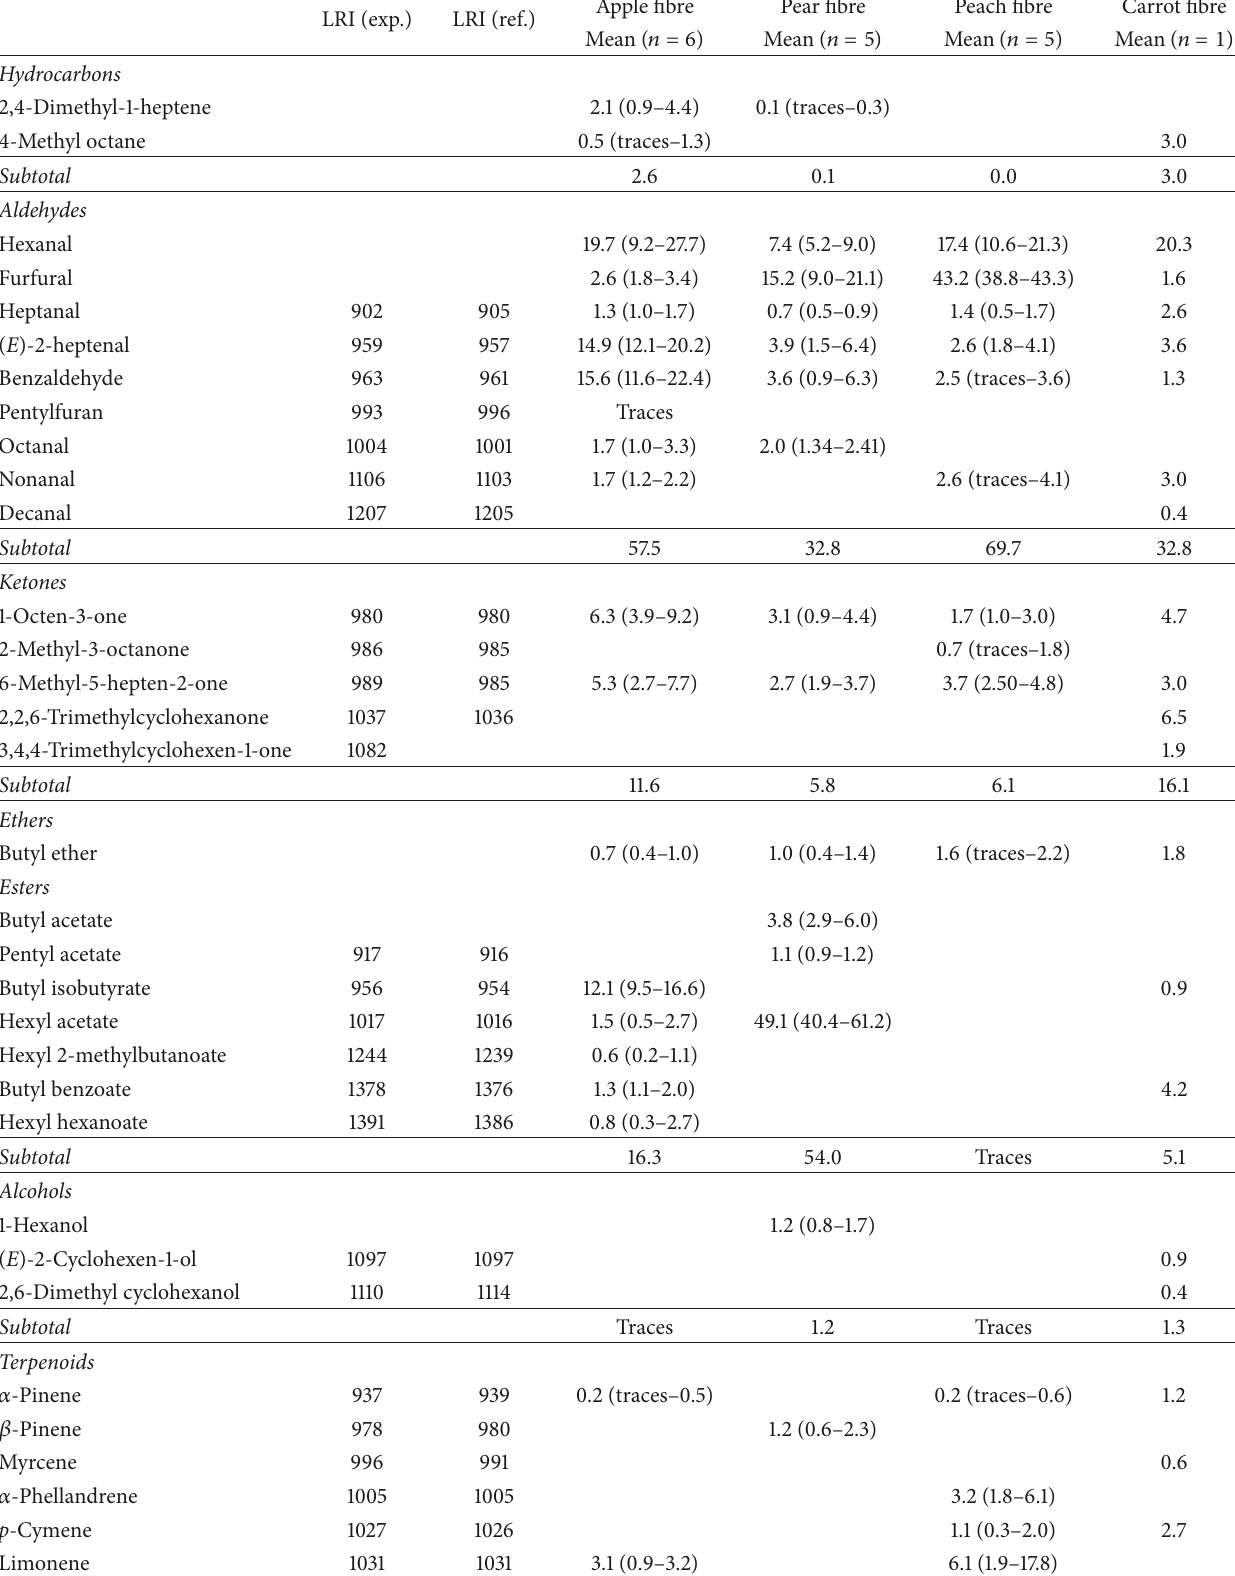
Table 2: Average relative percentage of volatile compounds present and their distribution ranges in different production batches (in parenthesis) of apple, pear, peach, and carrot fibres, as determined by HS-SPME-GC-MS